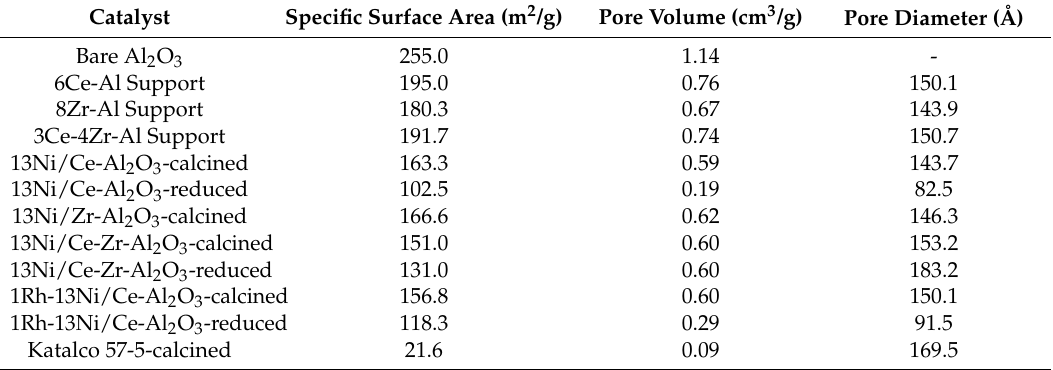
Table 1. Calcined catalysts specific surface area (SSA), pore volume (PV) and average pore diameter (PD).